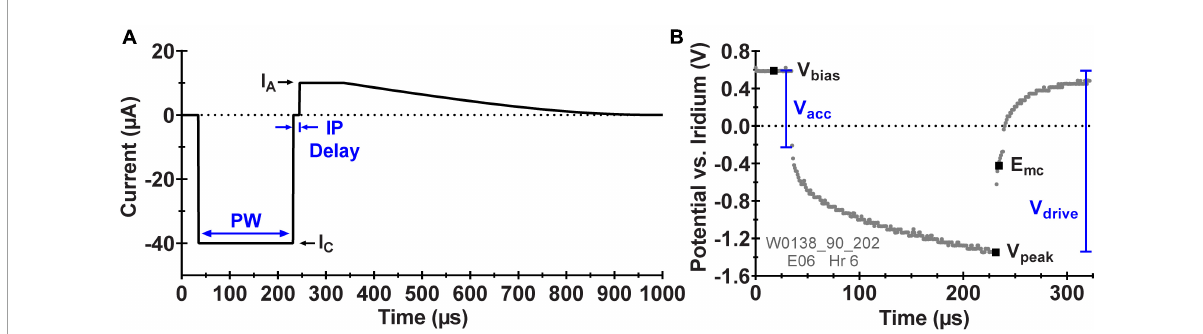
FIGURE2 (A) Schematic diagram of the asymmetric, biphasic current waveform applied by the ASIC during pulsing with the WFMA labeled with the pulse width (PW), cathodic current amplitude (I C ), anodic current amplitude (I A ), and interphase delay (IP Delay). (B) Example in vivo voltage transient (VT) response to pulsing at 40 µ A labeled with the set interpulse voltage bias (V bias ), the most negative voltage excursion (V peak ), and analysis parameters: maximum cathodic polarization potential (E mc ), access voltage (V acc ), and driving voltage (V drive